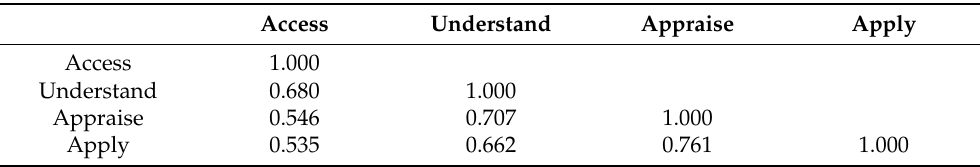
Table 2. Correlation matrix between the dimensions of BLAI.